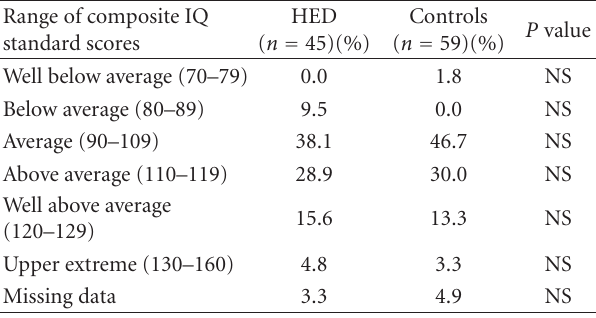
Table 3: Distribution of cognitive scores on K-BIT in children with HED and control group.